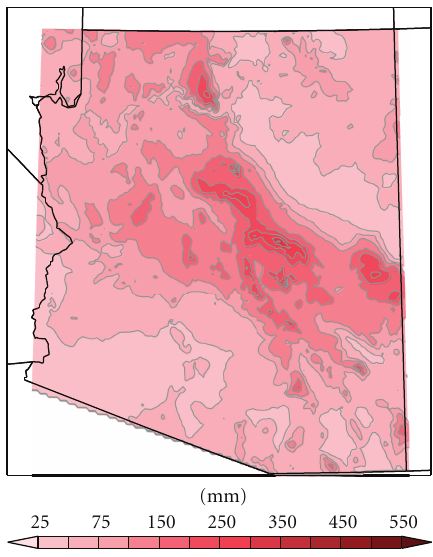
Figure 4: The cumulative observed rainfall for winter season (November 1–January 31), averaged over 7 winters from 2003 to 2009, using the PRISM monthly